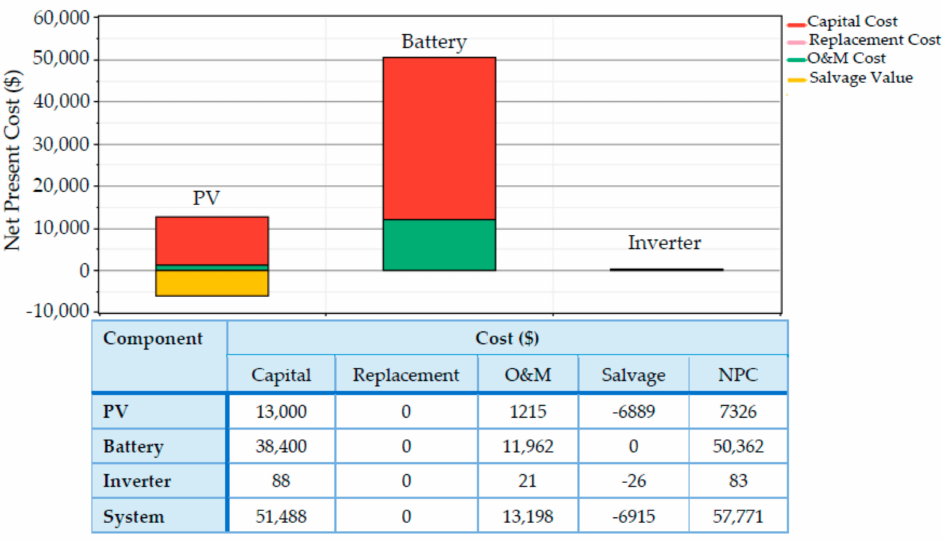
Figure 17. Summary of the net present cost for the system’s